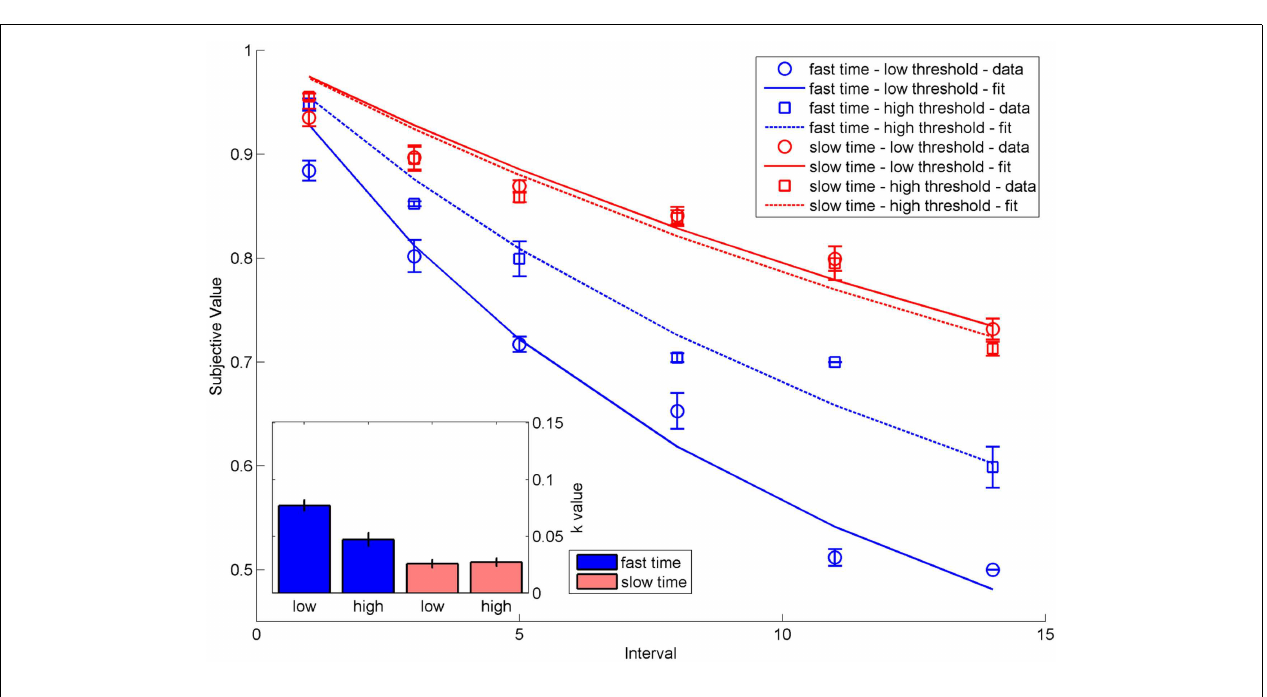
threshold, slow time accumulation – high threshold. Error bars indicate standard errors.The inset shows the k -values of hyperbolic functions fit to the respective data. Error bars show standard deviations.